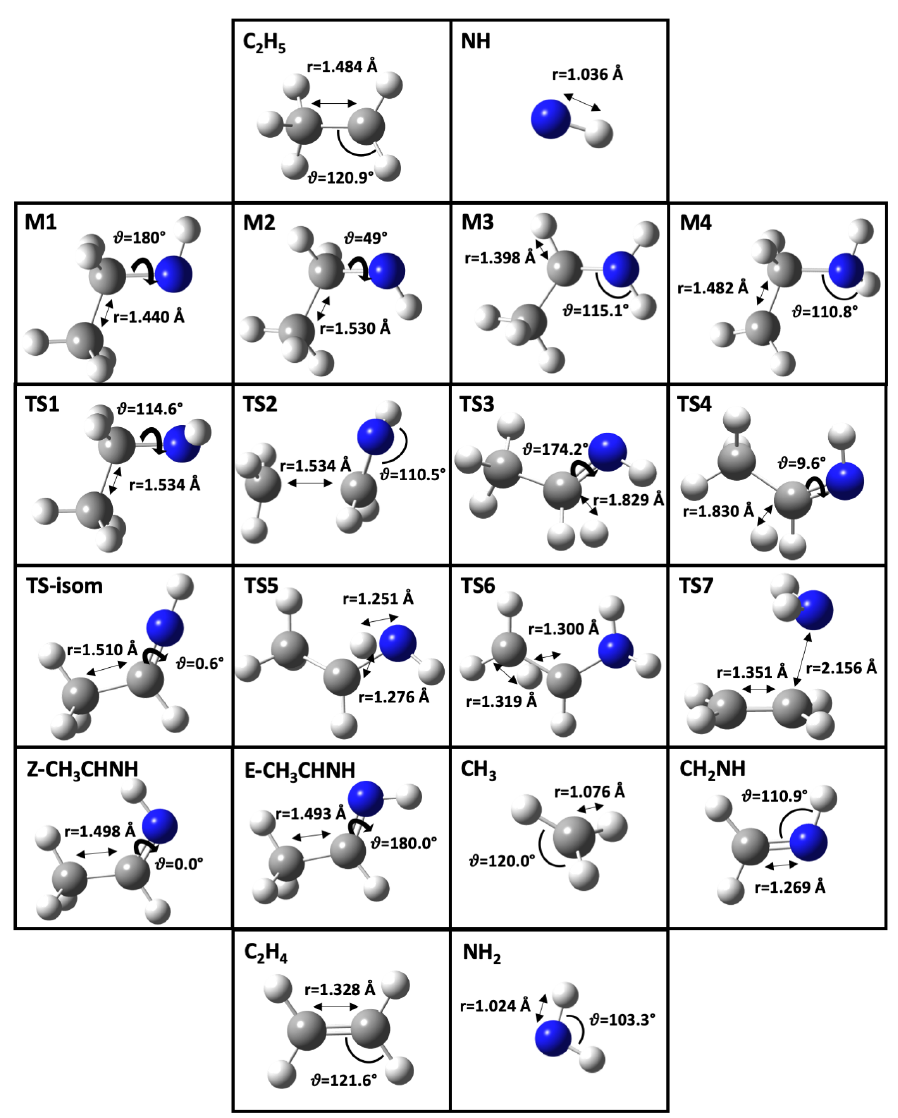
Figure 1. Structures and selected geometrical parameters of all stationary points on the ethanimine PES optimized at the B2 level. Bond lengths are in Å, whereas HNC ( ϕ ), HCH ( ϕ ’) or HNH ( ϕ ”) valence angles and CCNH ( ϑ ) dihedral angles are in